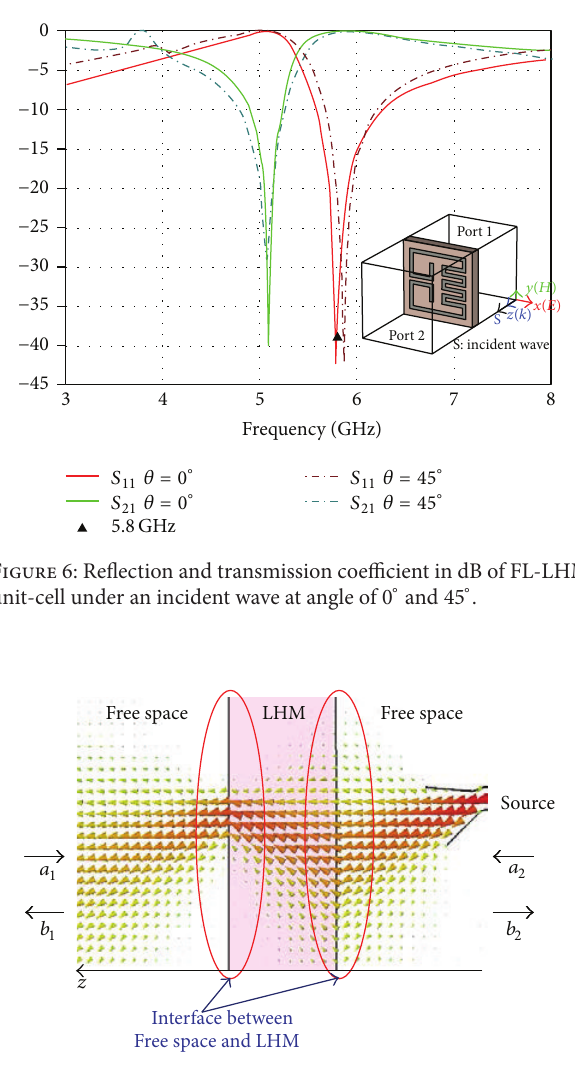
Figure 7: Wave propagation of an infinite slab FL-LHM in free space.